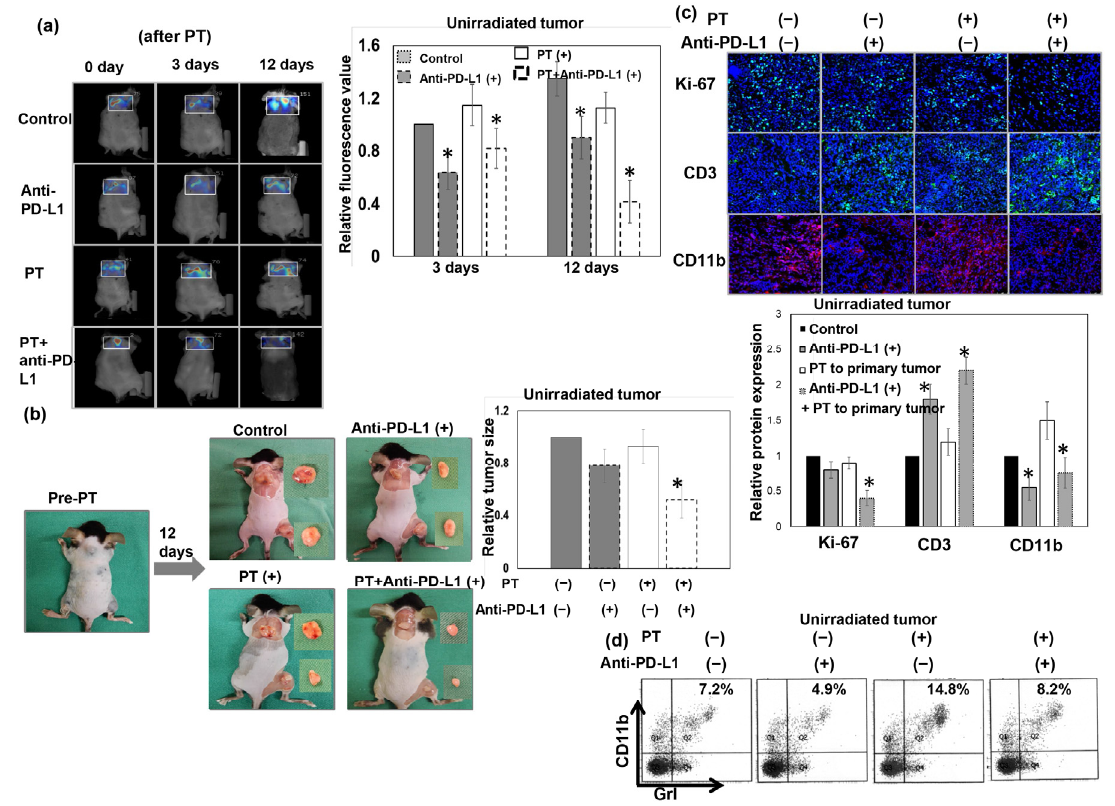
Figure 7. The abscopal effect on liver cancer following PT. The growth of unirradiated tumors over the upper back was determined via FMT analysis of glucose uptake ( a ) and tumor pictures ( b ) at indicated times from mice that received PT for 12 Gy (RBE) to the primary tumor over the right thigh only (PT (+): the mice received 12 Gy (RBE) to the primary tumor over right thigh, but not to the secondary tumor over the upper back). Representative images and quantitative data of unirradiated tumors are shown at 0, 3, and 12 days after PT irradiation with or without anti-PD-L1 therapy. The y axis represents the relative fold change in the value of FMT and tumor size at the indicated time after PT. Furthermore, representative images of the level of ki-67 and the infiltration of CD11b+ cells and CD3+ cells in secondary unirradiated tumors 12 days after local PT using IF are shown (DAPI, blue; ki-67 and CD3, green; CD11b, red) ( c ). The accumulation of MDSCs ( d ) in the secondary unirradiated tumor was analyzed using flow cytometry. The y axis is the relative fold change. Data represent the means of experiments, * p < 0.05.